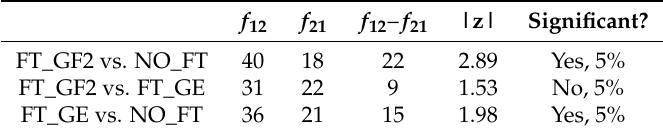
Table 4. Summary of the McNemar test to compare the difference between the classification results using different methods. f 12 and f 21 are the number of discordant pairs.